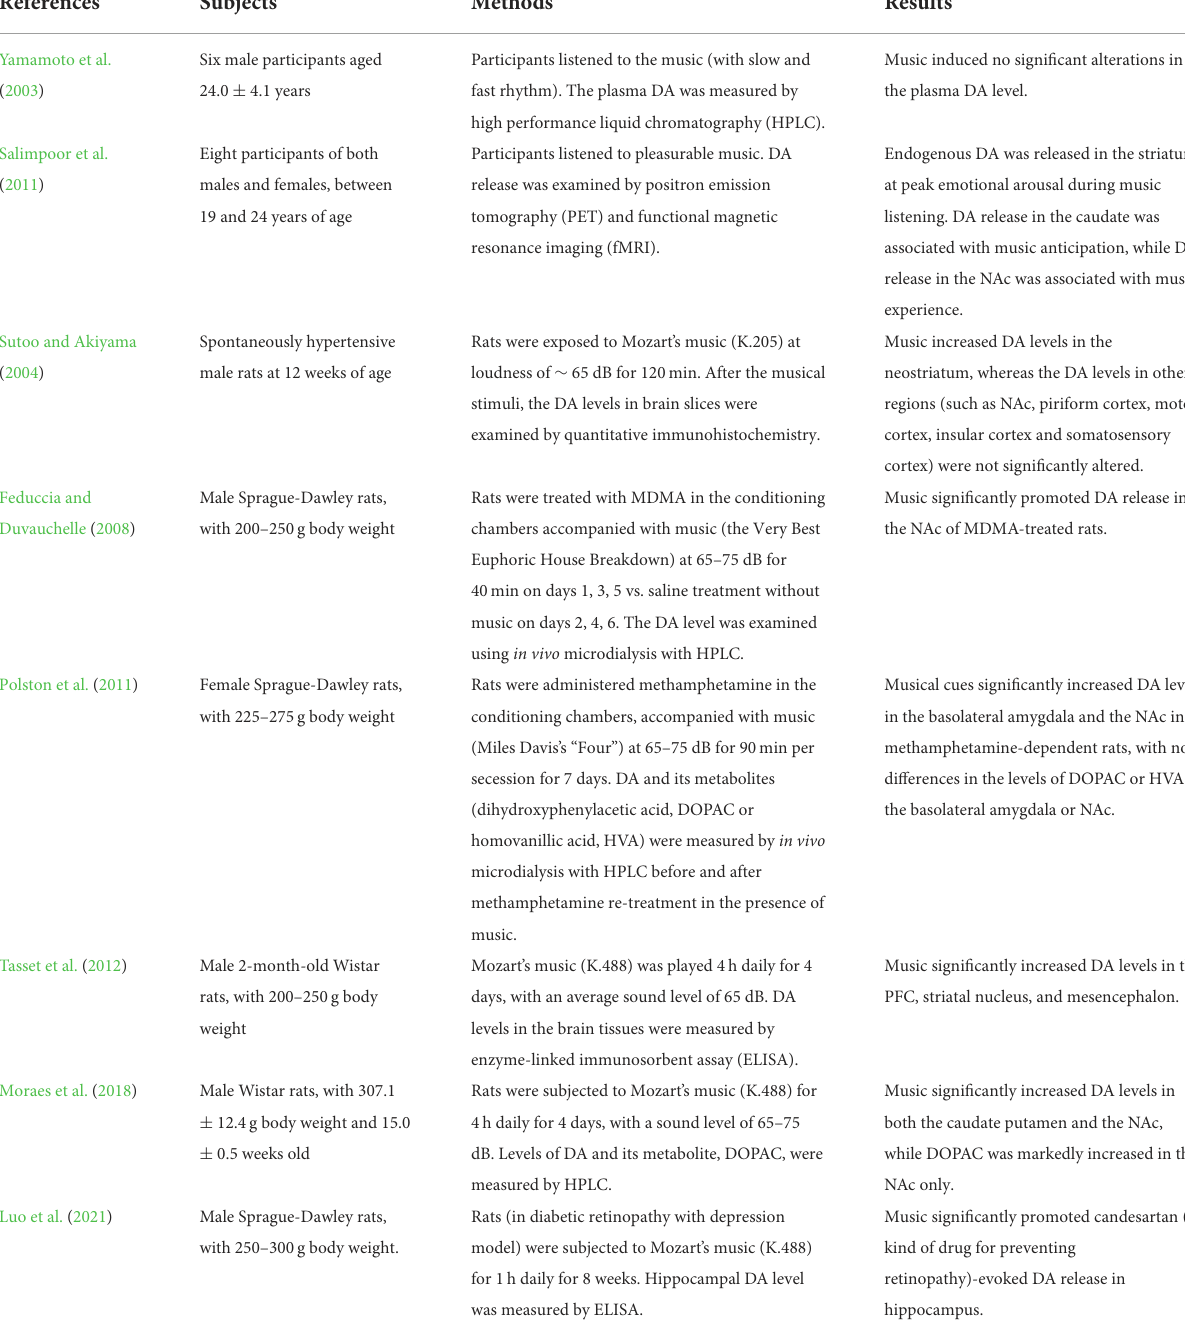
TABLE 2 Alterations of DA and its metabolites after music